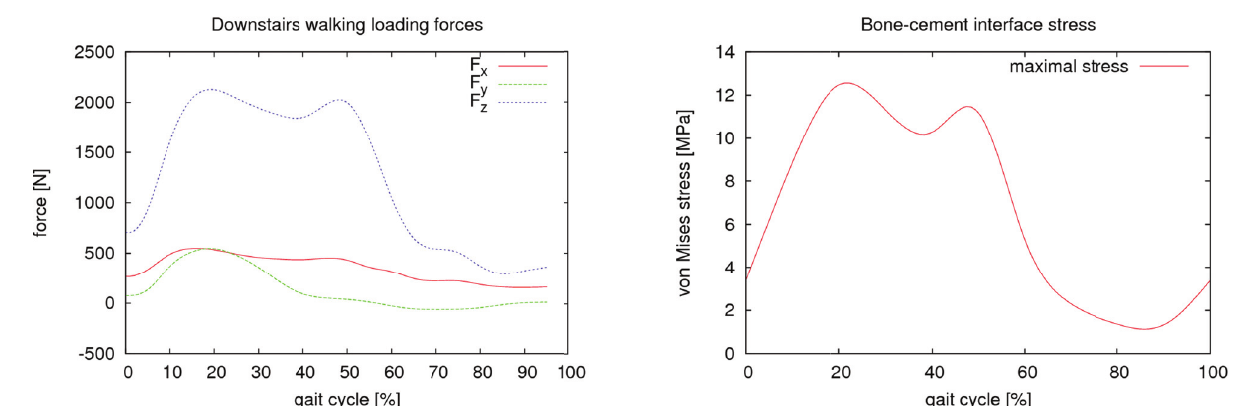
Figure 7: Resul observed to lo gions of pote